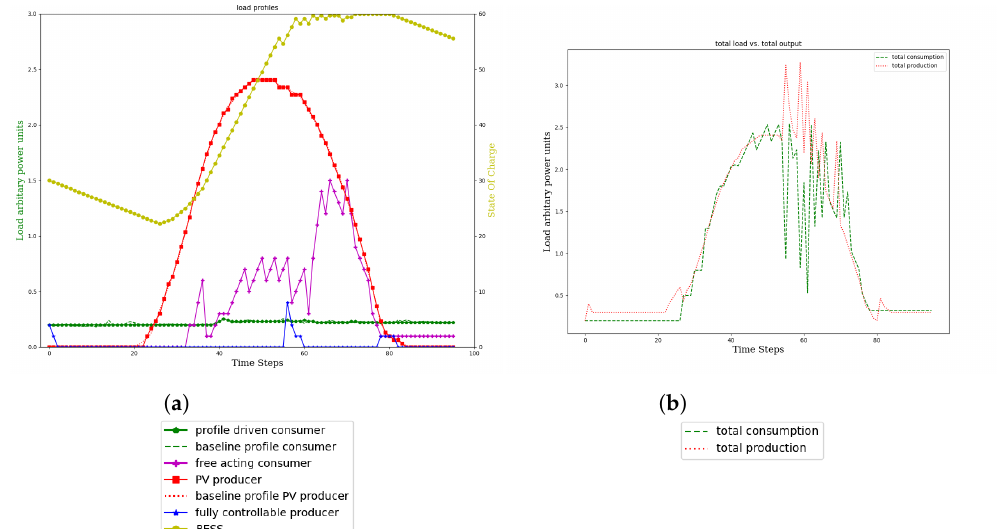
Figure 9. Evaluation on day 3, with agents trained on day 3. ( a ) Agent load curves and profiles. ( b ) Load balancing.